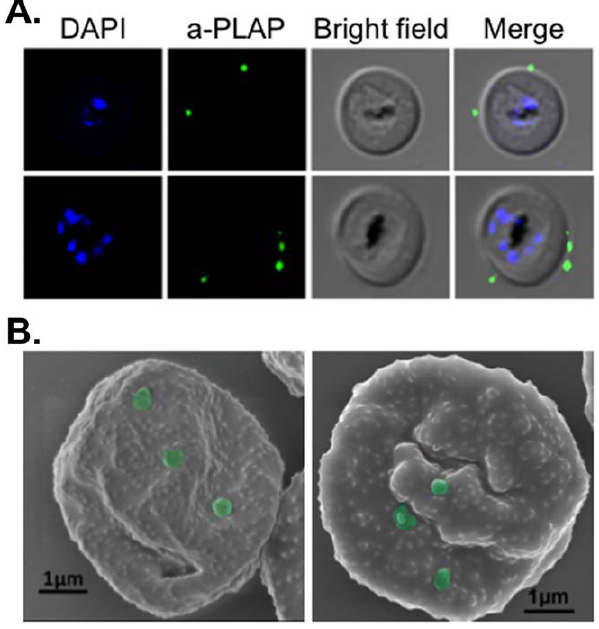
Figure 3. Adhesion intensity. ( a. ) Immunofluorescence with a vesicle-specific anti-placental alkaline phosphatase (PLAP) antibody and DAPI to stain the parasite DNA reveals a small number (2–4) of vesicles at the surface of IE. ( b. ) This is confirmed by scanning electron microscopy in which vesicles have been false-colored in green. Knob- like structures seen at the surface of the IE result from the extensive remodeling of the erythrocyte membrane by Plasmodium falciparum molecules. Bar size: 1 m m. Parasite line used: CS2.